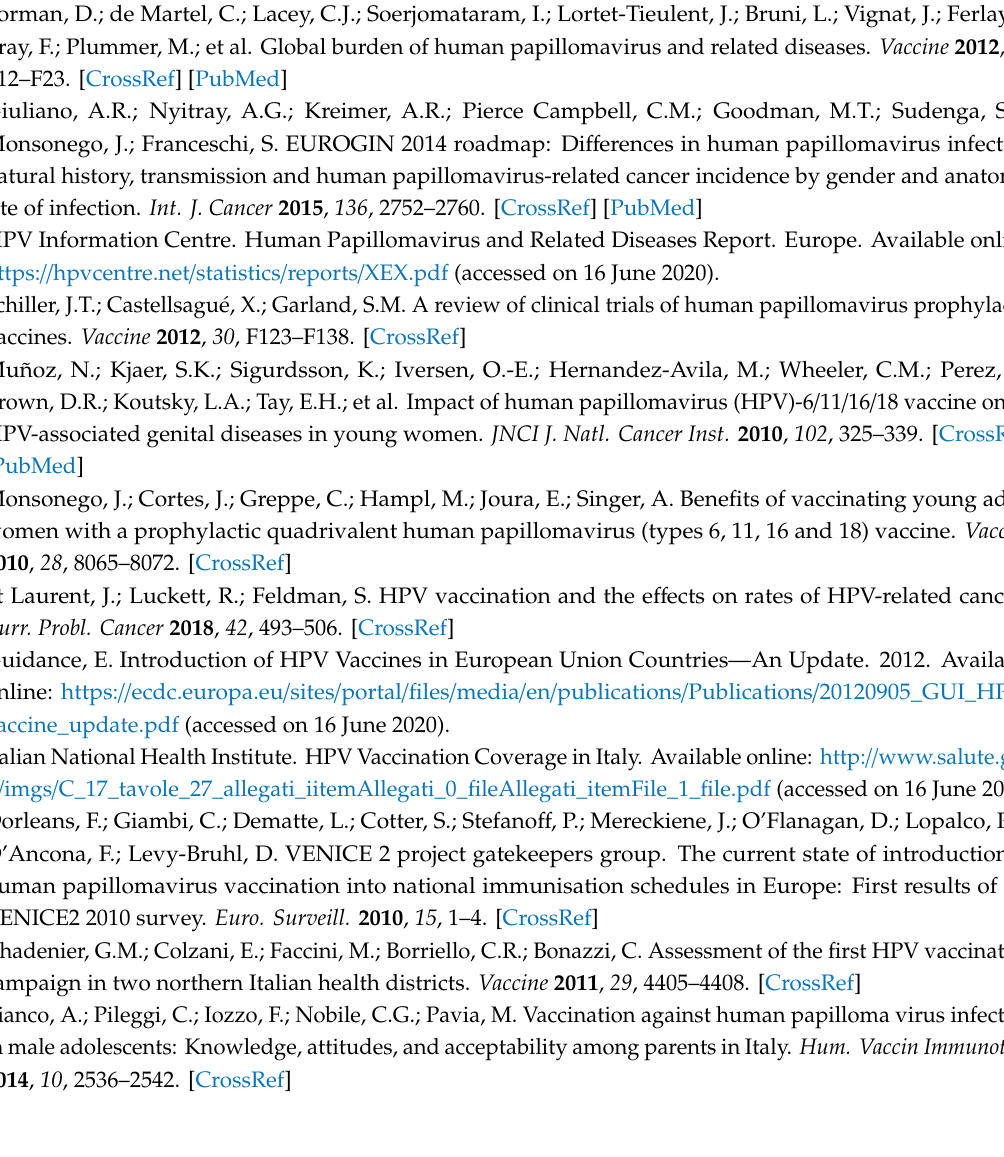
Table S1: Correct responses ( n / %) to individual knowledge of HPV items among all professional groups ( n = 1410); Table S2: Attitudes of health workers ( n / %) toward HPV infections, related diseases, and prevention statements; Table S3: Knowledge and attitude scores stratified by healthcare workers